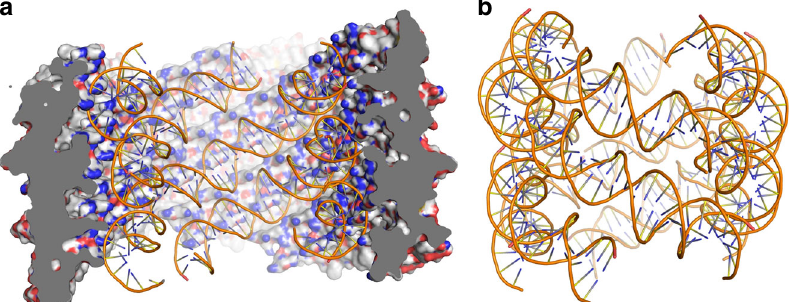
Fig. 3 APBV1 DNA adopts the left-handed superhelix form. a Electrostatic surface of APBV1 is shown from inside the virion. DNA follows the positively charged tracks made up by the residues Lys9 and Arg79 of the VP1 protein. b Model of APBV1 DNA shows a left-handed superhelical organization. The DNA passing through the middle of the DNA superhelix was not modeled